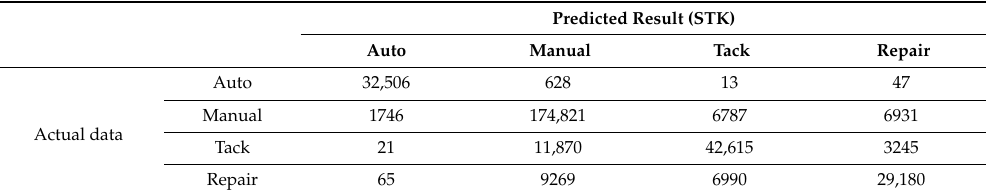
Table 9. Confusion matrix of the STK classification